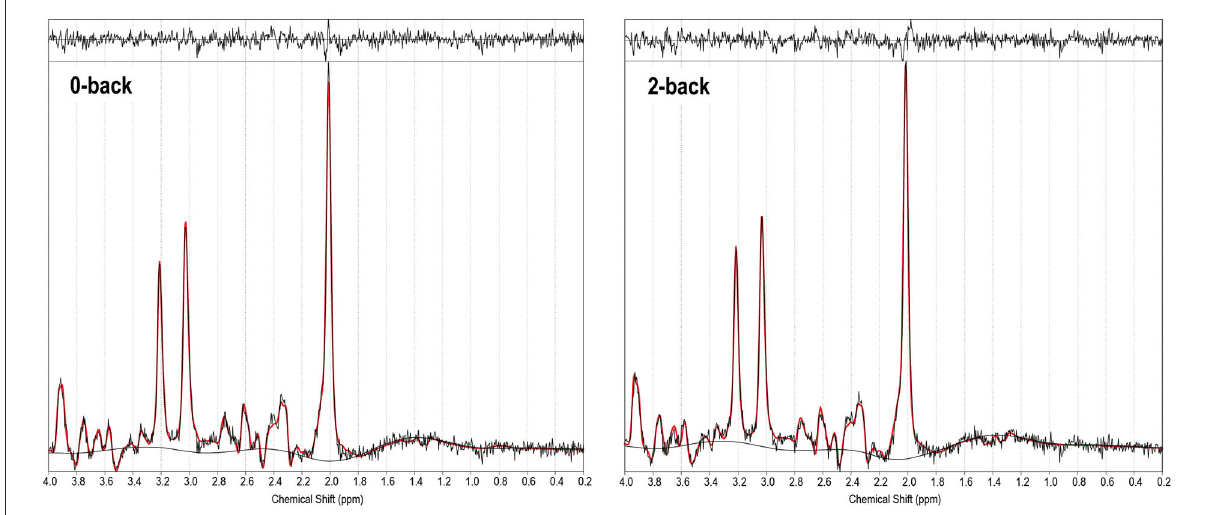
FIGURE3 1 H-fMRS spectra (for a single subject). TARQUIN output is shown for 0-back and 2-back conditions with output of the fit (red) overlaid on the acquired spectrum (black). The estimated baseline is displayed under each spectrum in black. For this single subject example, for the 0-back